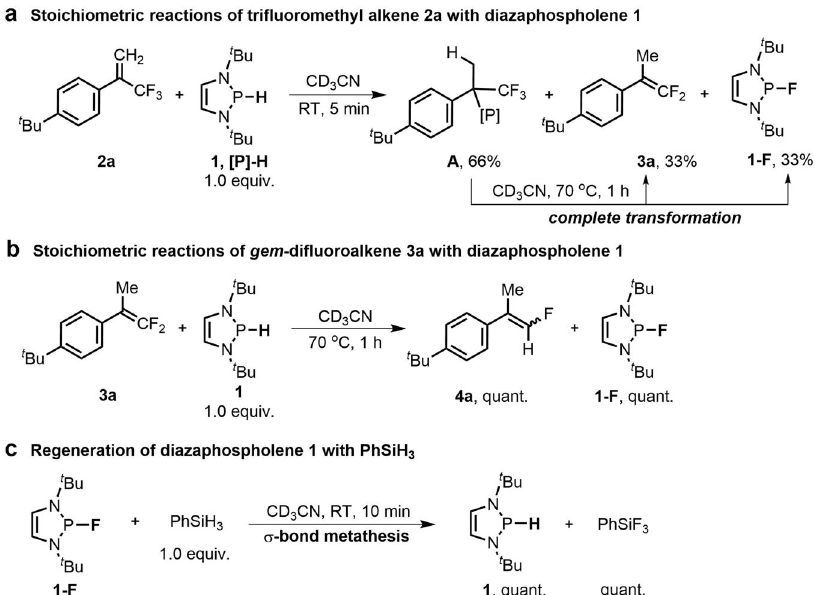
Fig. 3 Investigation of reaction conditions. a Stoichiometric reactions of the alkene 2a with diazaphospholene 1 . b Stoichiometric reactions of 3a with 1 . c Regeneration of diazaphospholene 1